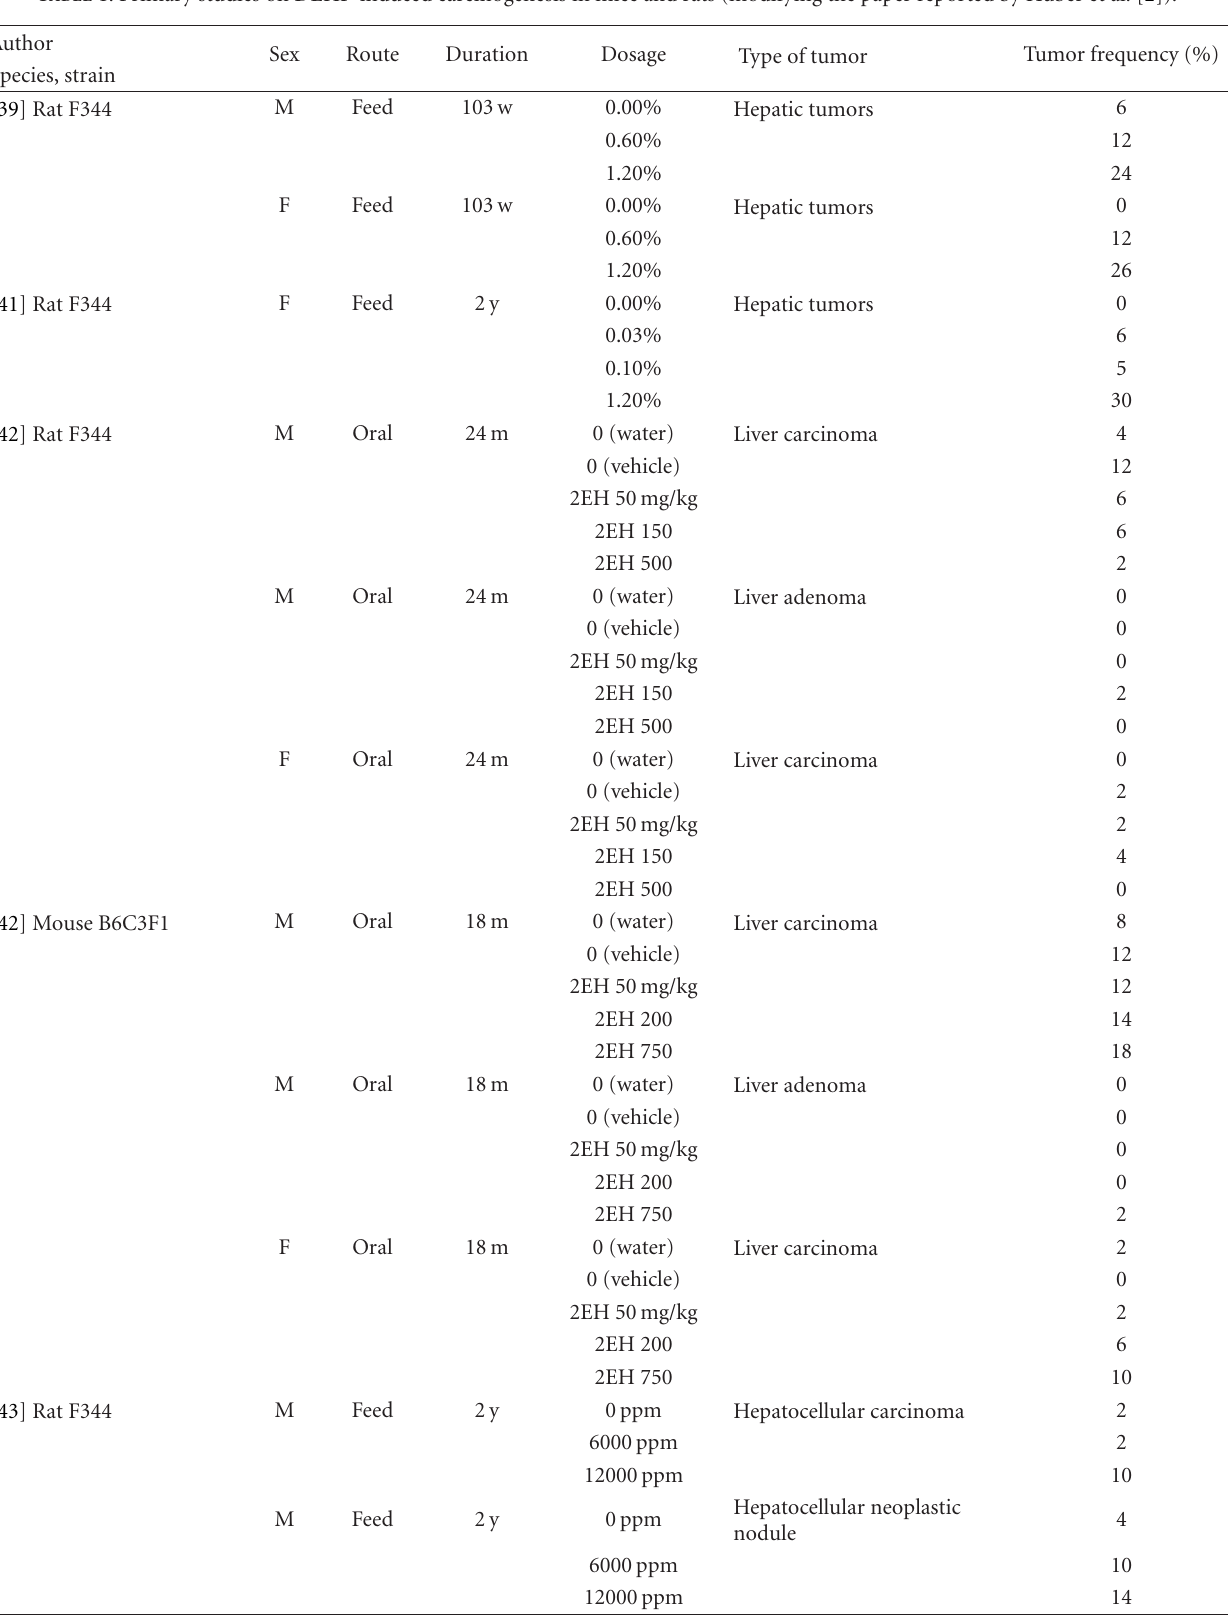
Table 1: Primary studies on DEHP-induced carcinogenesis in mice and rats (modifying the paper reported by Huber et al. [2]).